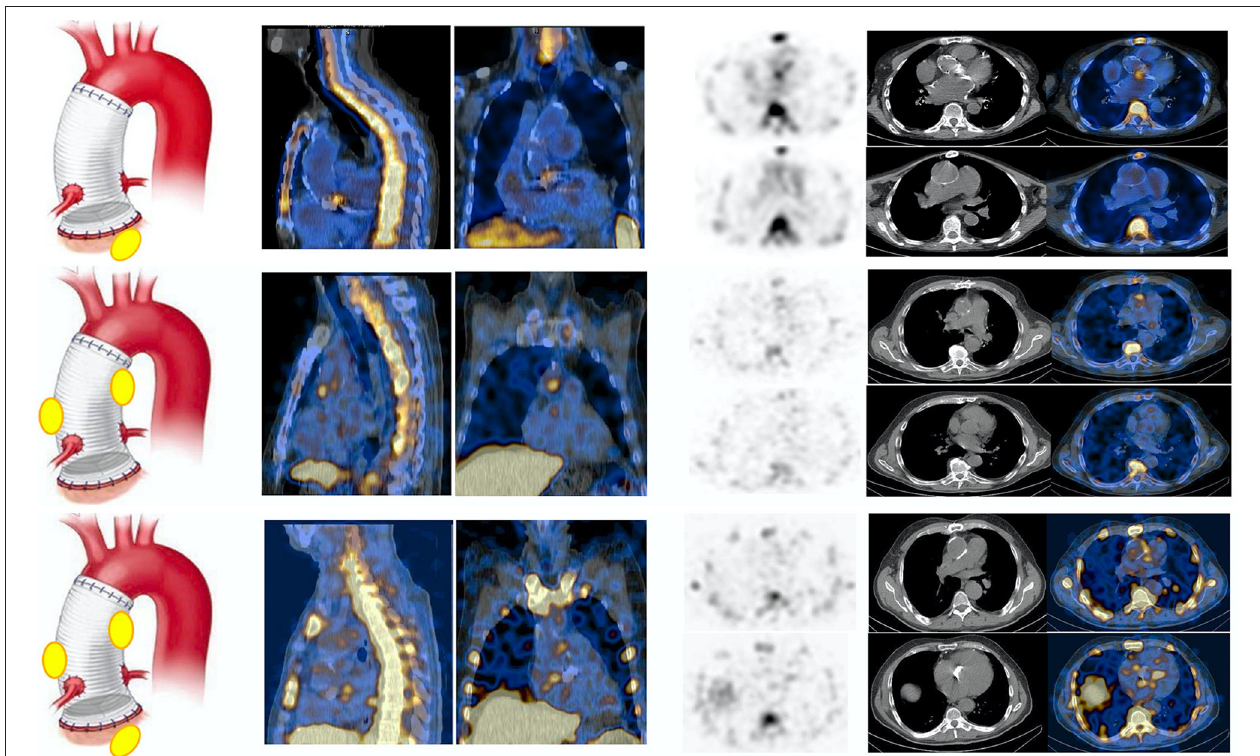
FIGURE 2 | Example of white blood cell ( 99m Tc-HMPAO-WBC) scan in patients with final diagnosis infection involving the AV (upper panel), the TG (middle panel), and at both the AV and TG (AVTG, lower panel) as shown by the SPECT/CT images of the thorax (from left to right, superimposed sagittal and coronal and transaxial emission, CT and superimposed SPECT/CT images at both the TG and the AV levels) showing area of focal radiopharmaceutical uptake involving either the aortic prosthetic valve, the tube graft, or both. The left panel of the figure shows a schematic representation of the final diagnostic